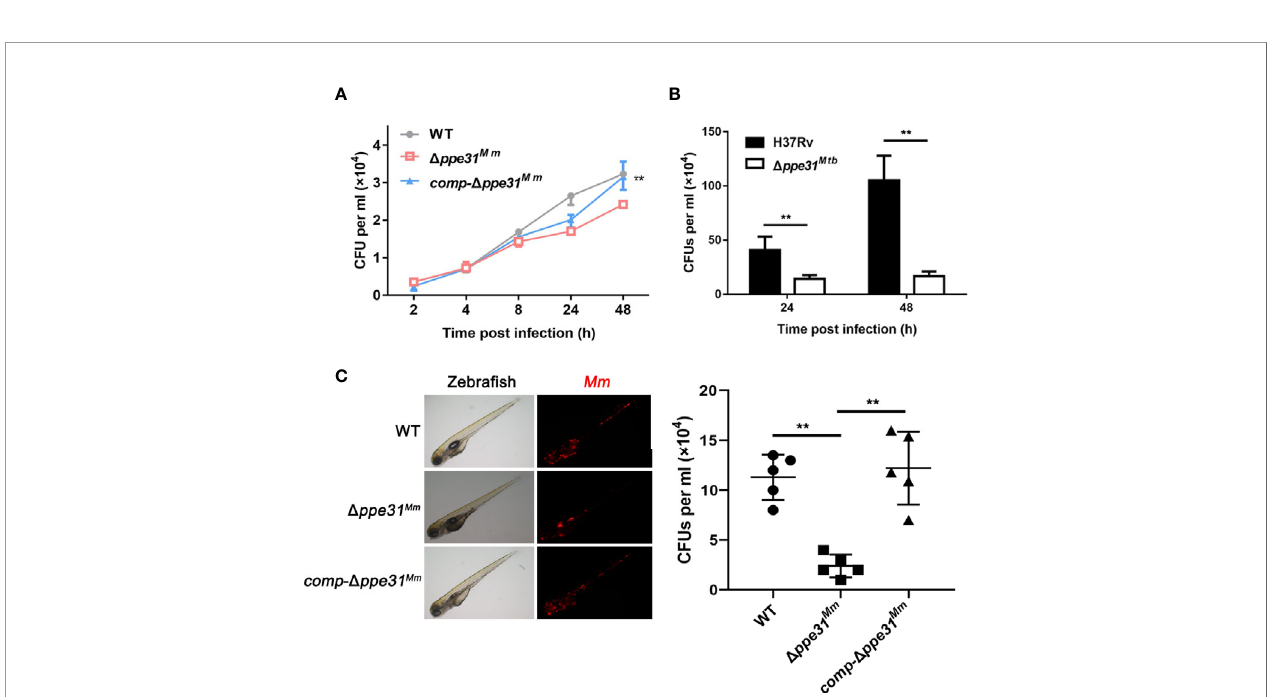
FIGURE 6 | PPE31 promotes mycobacteria survival in macrophage and in zebra fi sh. (A) WT, D ppe31 Mm or comp- D ppe31 Mm -infected BMDMs were analyzed for number of surviving internalized bacilli by CFU counting at the indicated time. (B) H37Rv or D ppe31 Mtb -infected RAW264.7 cells were analyzed for number of surviving internalized bacilli by CFU counting at the indicated time. (C) Bacterial survival advantage in the infected zebra fi sh. Three hundred CFU of M. marinum strains were injected to reach a comparable infection level at 4 dpi. Representative burden pictures and representative burden analysis derive from larvae collected at 4 dpi. Each point in represents 1 infected larva from a representative pool. Scale bar in 200 m m. Data are shown as mean±S.E.M. of three independent experiments. ** p < 0.01. WT, wild-type M. marinum ; UI,